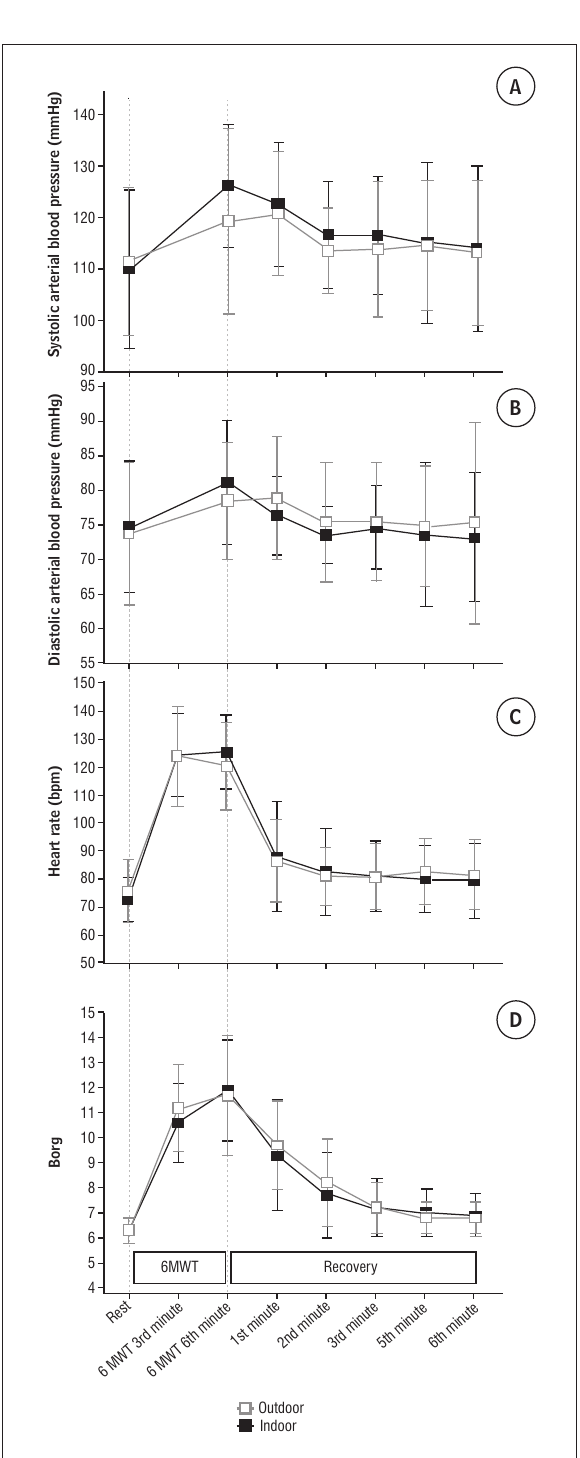
Figure 1 - Physiological data obtained during 6MWT in open and closed